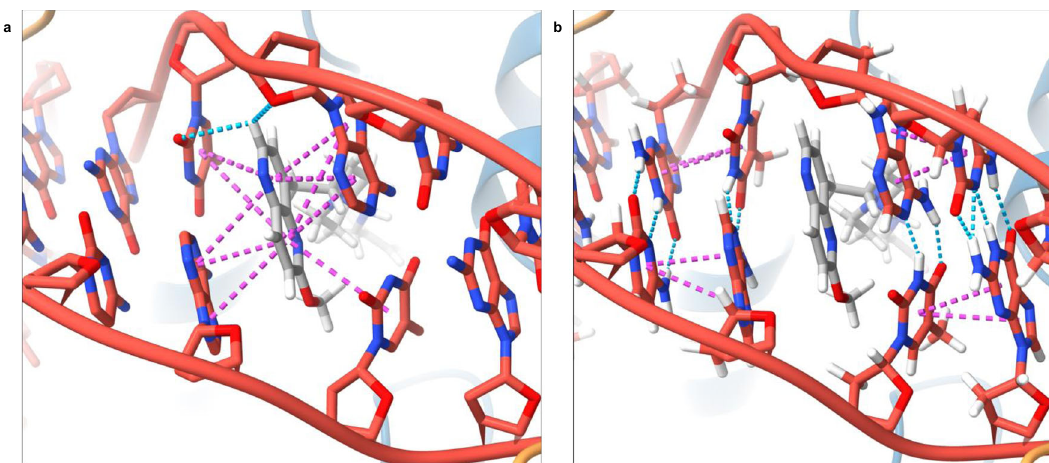
Fig. 6 Intercalation of LHS between symmetrical DNA base pairs. a Stabilization of asymmetric LHS of 4 (sticks representation colour coded by element) by stacking interactions causes uneven rotation of surrounding DNA base pairs (cartoon representation in red), thus breaking DNA symmetry. Stacking interactions are represented as magenta dots, while pseudo hydrogen bonds are represented as blue dots. b Interaction network of DNA base pairs affected by LHS